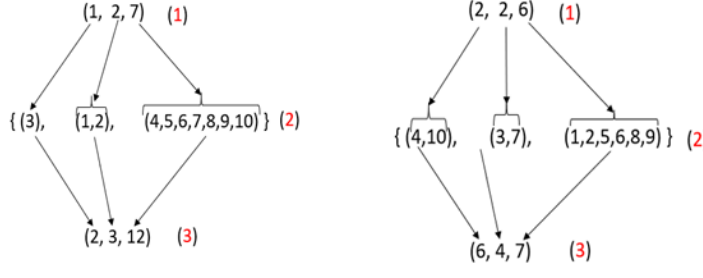
Figure 1. Transformation of strategies with homogeneous resources into strategies with heterogeneous